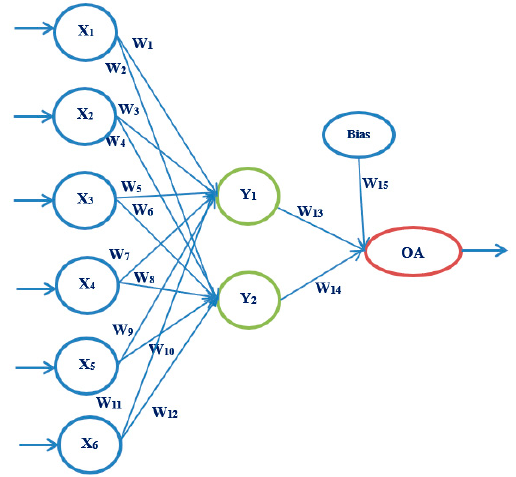
Figure 2. ANN architecture with one hidden layer based on OA12 (ANN-OA12).